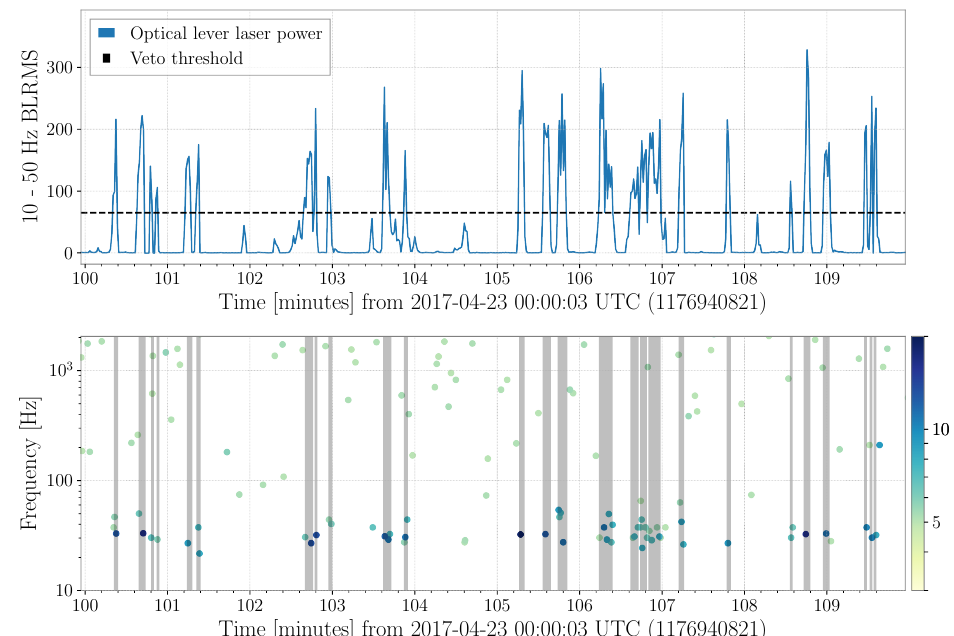
Figure 5. An example of the design and effectiveness of a data quality veto. This data quality veto was designed to remove time periods with glitches from fluctuations in the power of a laser used to control the alignment of a mirror (referred to as an “optical lever”). Top: The root-mean-square of the optical lever laser power after bandpassing between 10 and 50 Hz. The veto threshold is denoted with a black dashed line. Bottom: The time and frequency of glitches in the gravitational-wave strain data as identified by Omicron [35,36]. The color of dots indicates the SNR of the glitch. Time above the veto threshold are shaded in gray. These times represent all of the loud glitches in this time period. Figure reproduced from [18]. © IOP Publishing. Reproduced with permission. All rights